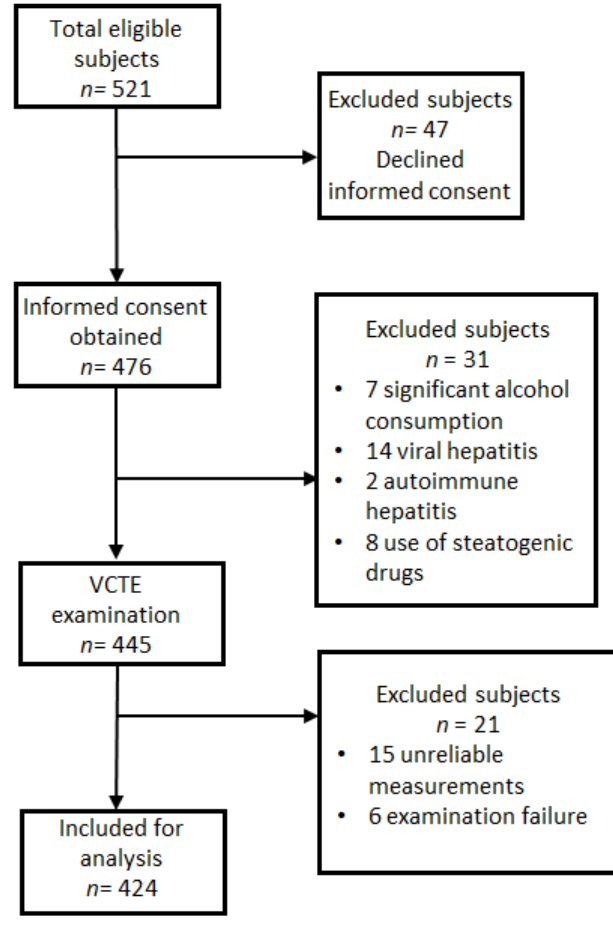
Figure 1. Participant flowchart. A total of 97 subjects were ruled out from the study. In the final analysis, we included 424 patients who accomplished the admission criteria. Of these patients with a mean age of 53.67 ± 11.37 years, 331 (78.1%) of them were evaluated by the M probe, and 93 (21.9%) were evaluated by the XL probe. All baseline characteristics are presented in Table 1. Most of the participants had a BMI ≥ 25 kg/m2 (84.8%) with a higher number of female participants (51.7%). Hypertension and metabolic syndrome were present in 246 (58%) and 229 (54%) patients,